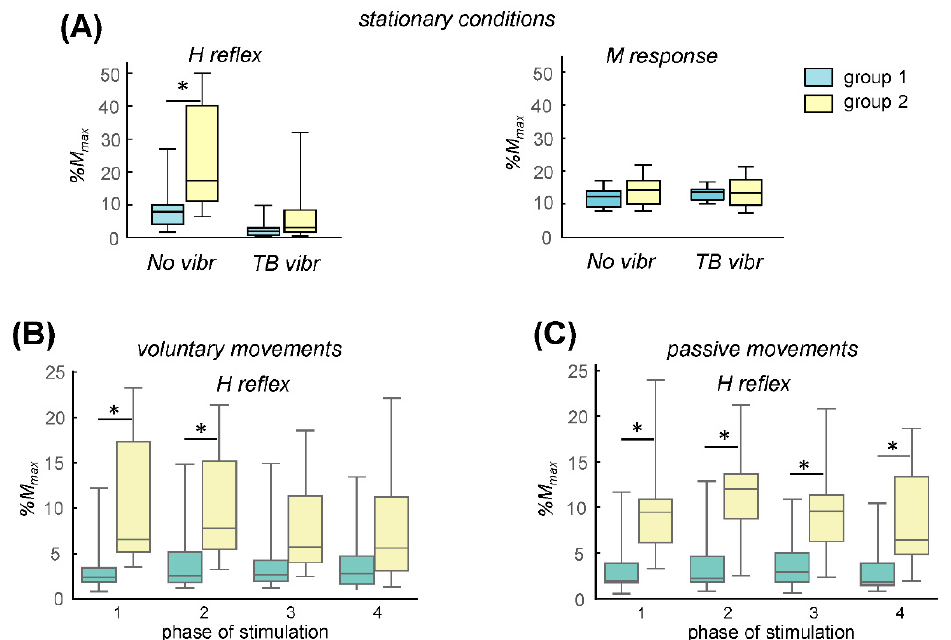
Figure 4. H-reflex amplitudes (median and quartiles) for the two groups of subjects measured during stationary conditions ( A )—rhythmic voluntary arm movements, ( B )—passive upper limb oscillations, ( C )—in the former case (panel A), two stationary conditions were analyzed: no vibration and TB (triceps brachii) vibration. Corresponding M-responses are also plotted in the right panel. In the latter cases (panels B and C), H-reflex measurements were compared during 4 phases of movements (Figure 3A). Asterisks denote significant differences between the two groups.